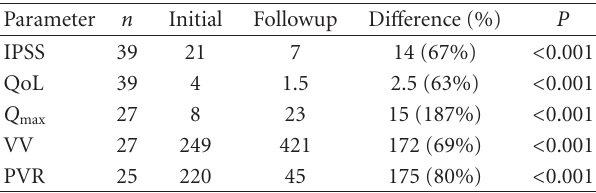
Table 4: Paired long-term outcome results